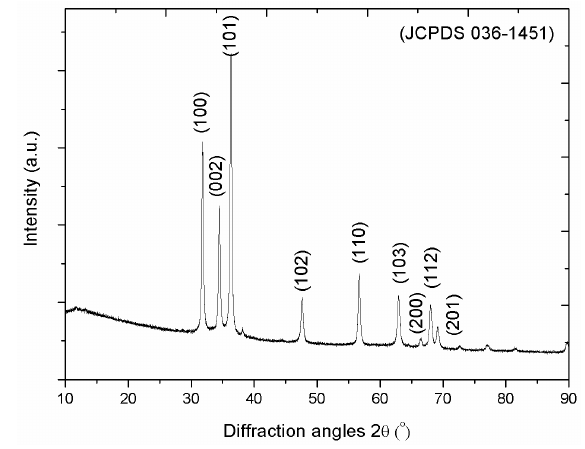
Figure 2. Indexed XRD pattern of sample S1.